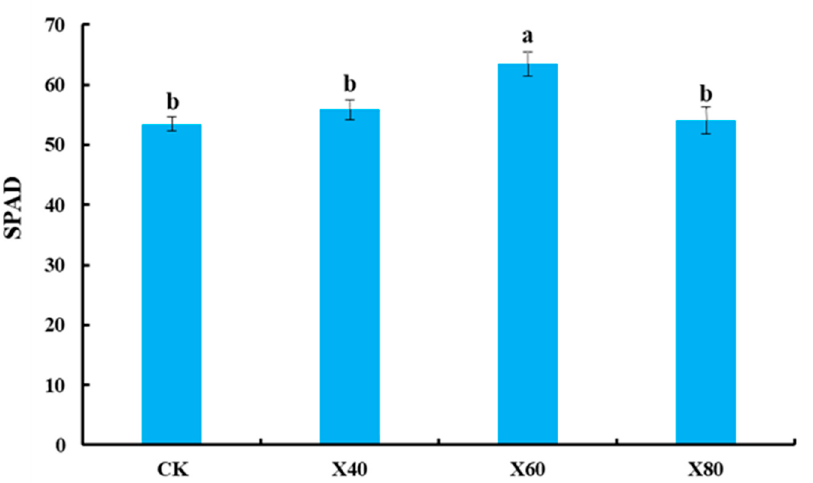
Figure 2. Relative chlorophyll content (SPAD) in L. barbarum leaves under different root restriction treatments. Note: Different letters show significant differences determined by LSD’s test at p < 0.05.